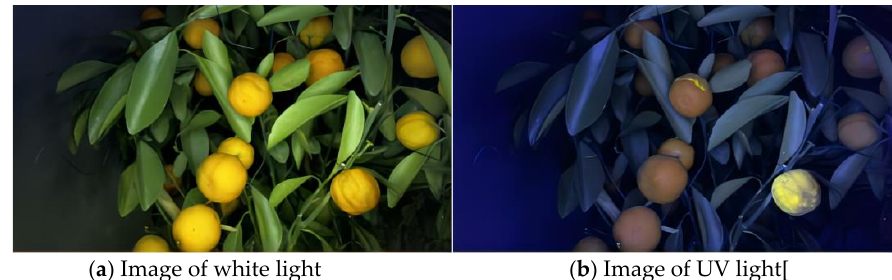
Figure 5. Images of white light and UV light of nighttime citrus.